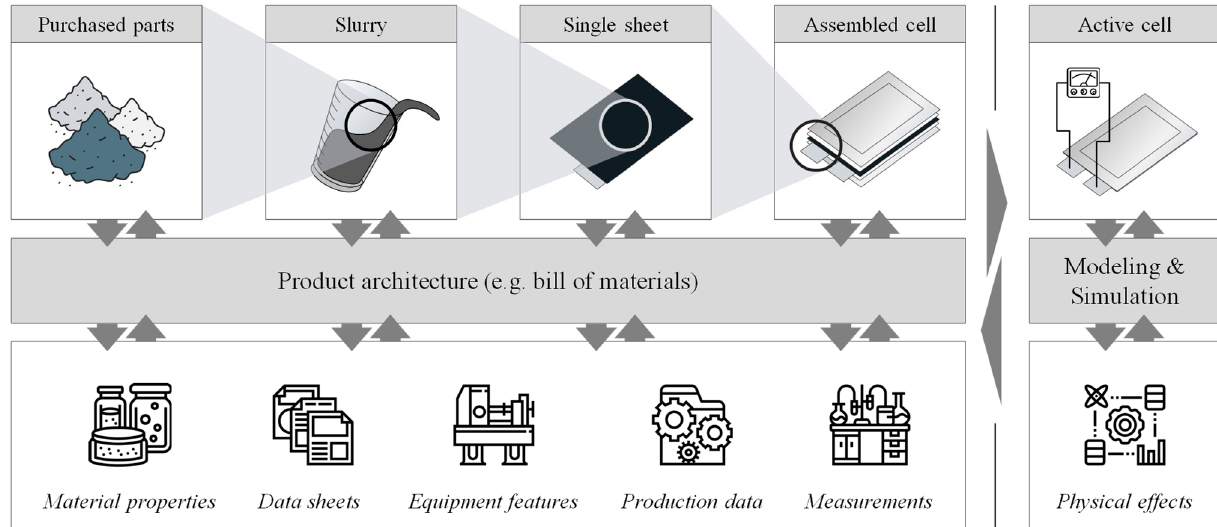
Figure 7. Framework for a semantic structure of a digital ba tt ery cell twin.